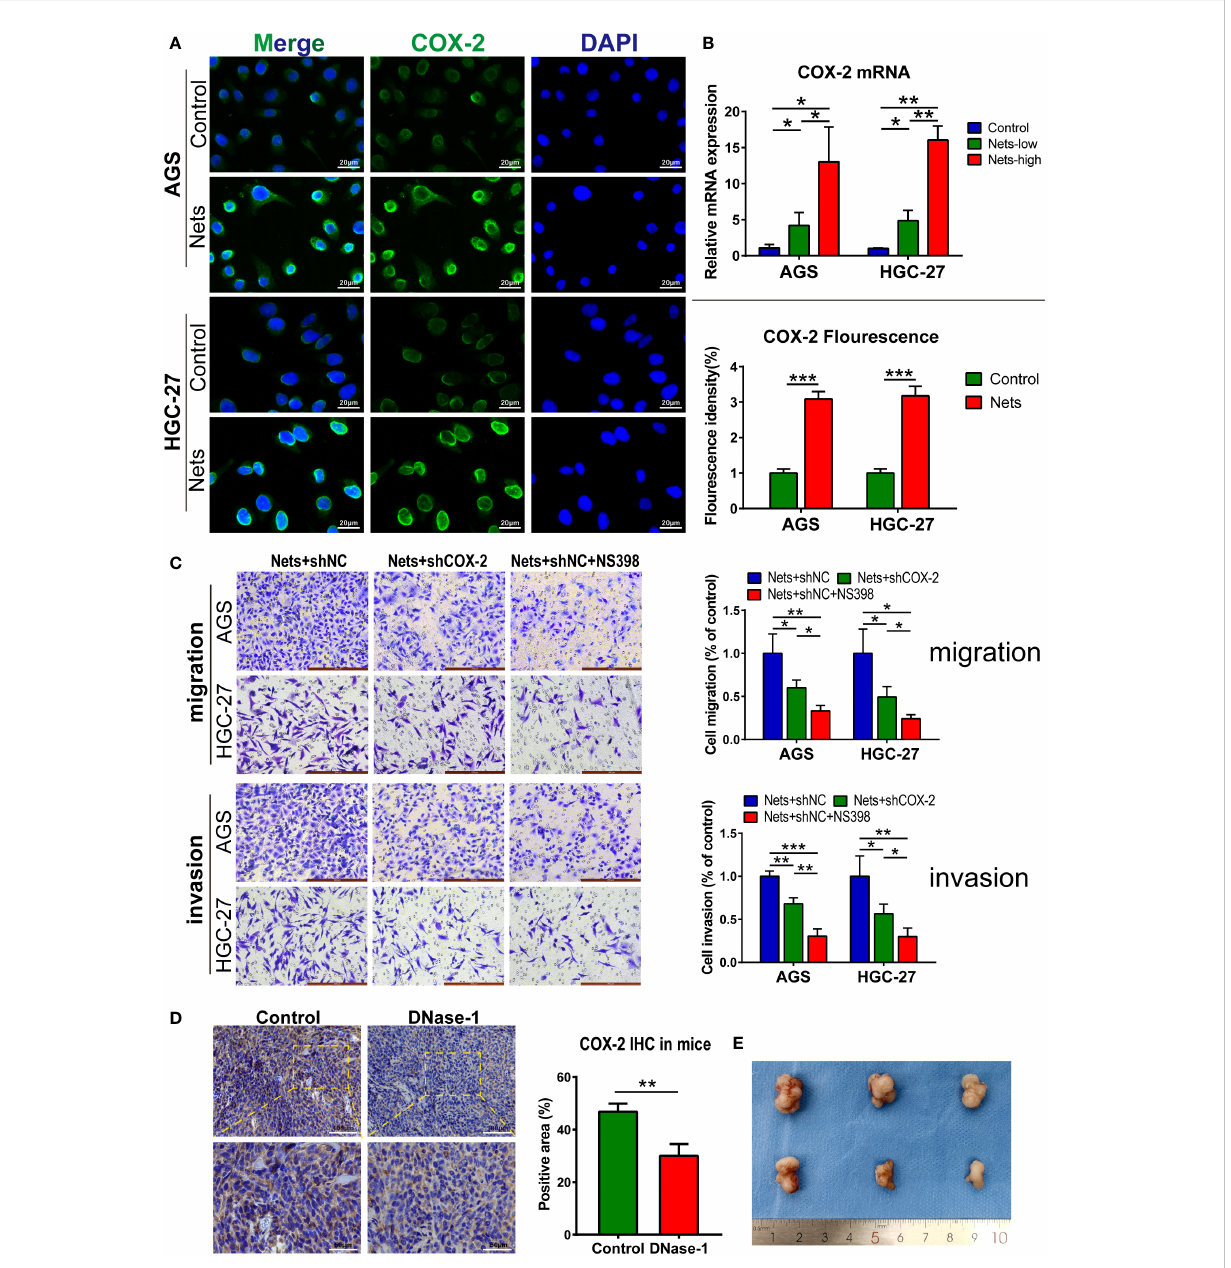
FIGURE 4 NETs promote gastric cancer metastasis by regulating COX-2. (A) Representative images of COX-2 distribution and expression in two gastric cancer cell lines after NETs stimulation. The COX-2 expression was evaluated by statistical fl uorescence intensity. (***p<0.001 vs. Control; n=3). (B) The mRNA expression of COX-2 in two gastric cancer cell lines changed with the NETs concentration. (*p<0.05; **p<0.01; n=3) (C) The number of cells stimulated by NETs passing through Transwell chambers was measured by migration and invasion assays and observed after crystal violet staining. NS398 addition and shCOX-2 transfection were used to simulate the inhibition of COX-2 in different degrees. Each group maintained the same concentration of NETs. (*p<0.05; **p<0.01; ***p<0.001; n=3) (D, E) The expression of COX-2 in subcutaneous tumor was decreased after the nude mice were intraperitoneal injected Dnase-1. We use the positive rate of immunohistochemistry to measure the expression of COX-2. Subcutaneous tumor specimens are shown on (E) . (**p<0.01 vs. Control; n=3). All results are presented as mean ±